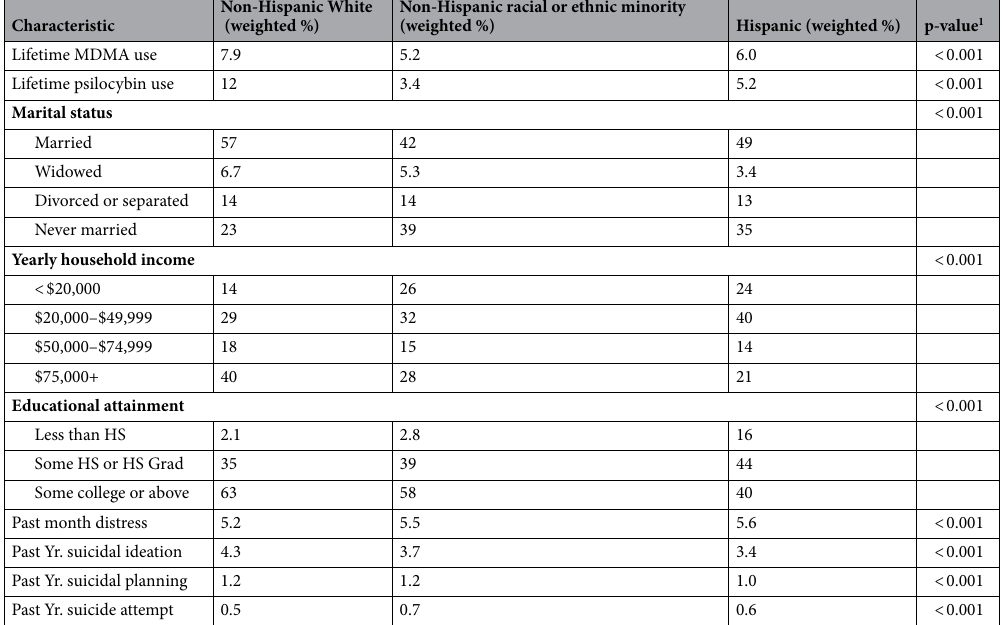
Table 1. Sample demographics and prevalence of psychedelic use, past month psychological distress, and past year suicidality, stratified by race and ethnicity. 1 Chi-squared test with Rao & Scott’s second-order correction.